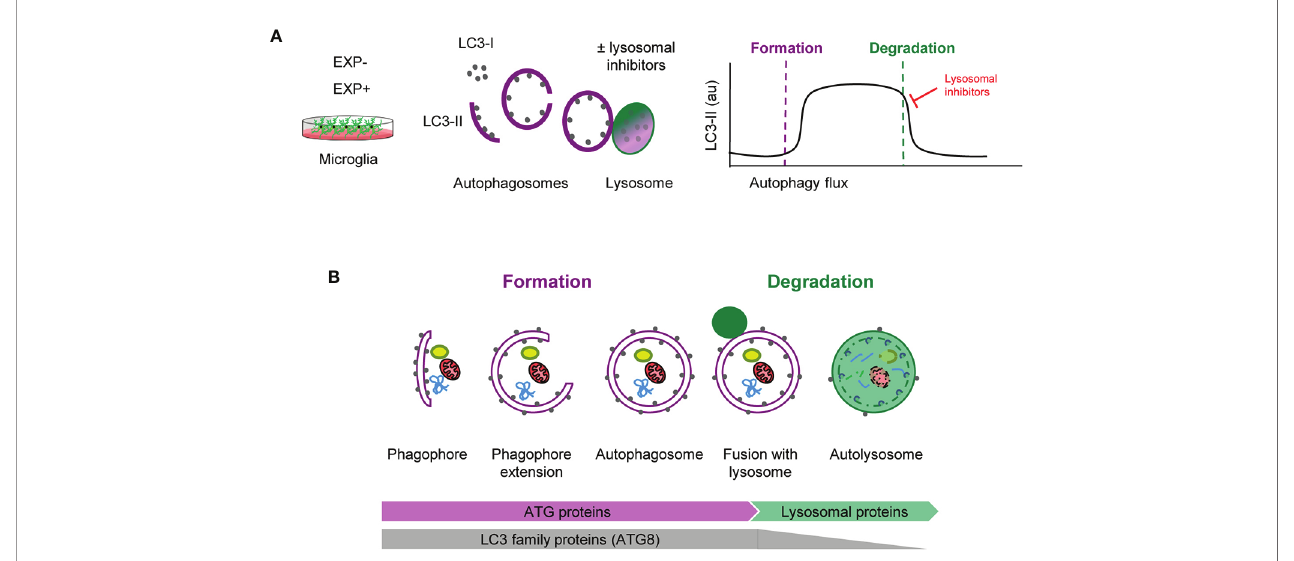
FIGURE 1 | Estimation of autophagy fl ux variations using LC3 turnover assay. (A) Total protein homogenates obtained from microglia under control (EXP - ) and experimental conditions (EXP + ) are analyzed by Western Blot to evaluate LC3 levels in the presence and absence of lysosomal inhibitors. When autophagy is activated, LC3-I (soluble form) is lipidated to the phophatidylethanolamine of the nascent phagophore forming LC3-II (membrane-bound form). LC3-II accumulates along the extension of the autophagic vacuoles as it closes and is used as an estimate of the number of autophagosomes. Upon fusion with lysosomes, LC3-II levels decrease due to the degradation of the inner autophagosomal membrane simultaneously with the luminal cargo. In the presence of lysosomal inhibitors, no degradation occurs and LC3-II levels are maintained. The subtraction of LC3-II quantities in the presence and absence of lysosomal inhibitors provides an estimate of the autophagosomes that have been degraded during the experimental period of time. (B) Early stages of autophagy, which lead to the de novo formation of autophagosomes, are mainly regulated by ATG proteins. The LC3 family of proteins (ATG8) participate in the formation of autophagosomes and progressively disappear after lysosomal fusion and cargo degradation in autolysosomes. Late stages of autophagy depend on the functionality of lysosomal proteins and